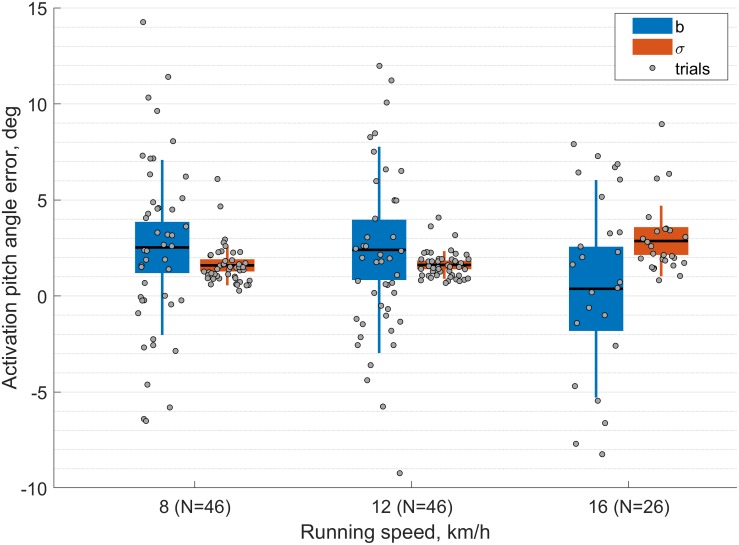
Boxplot of the intra-trial biases and precision results for the foot pitch activation angle [θJCA(AC)] measured with the proposed method (JCA). In the figure, the intra-trial biases are shown in blue and the precision values in orange. The gray dots represent the statistic of each trial. Note that there are two dots per trial because the feet were considered independently.